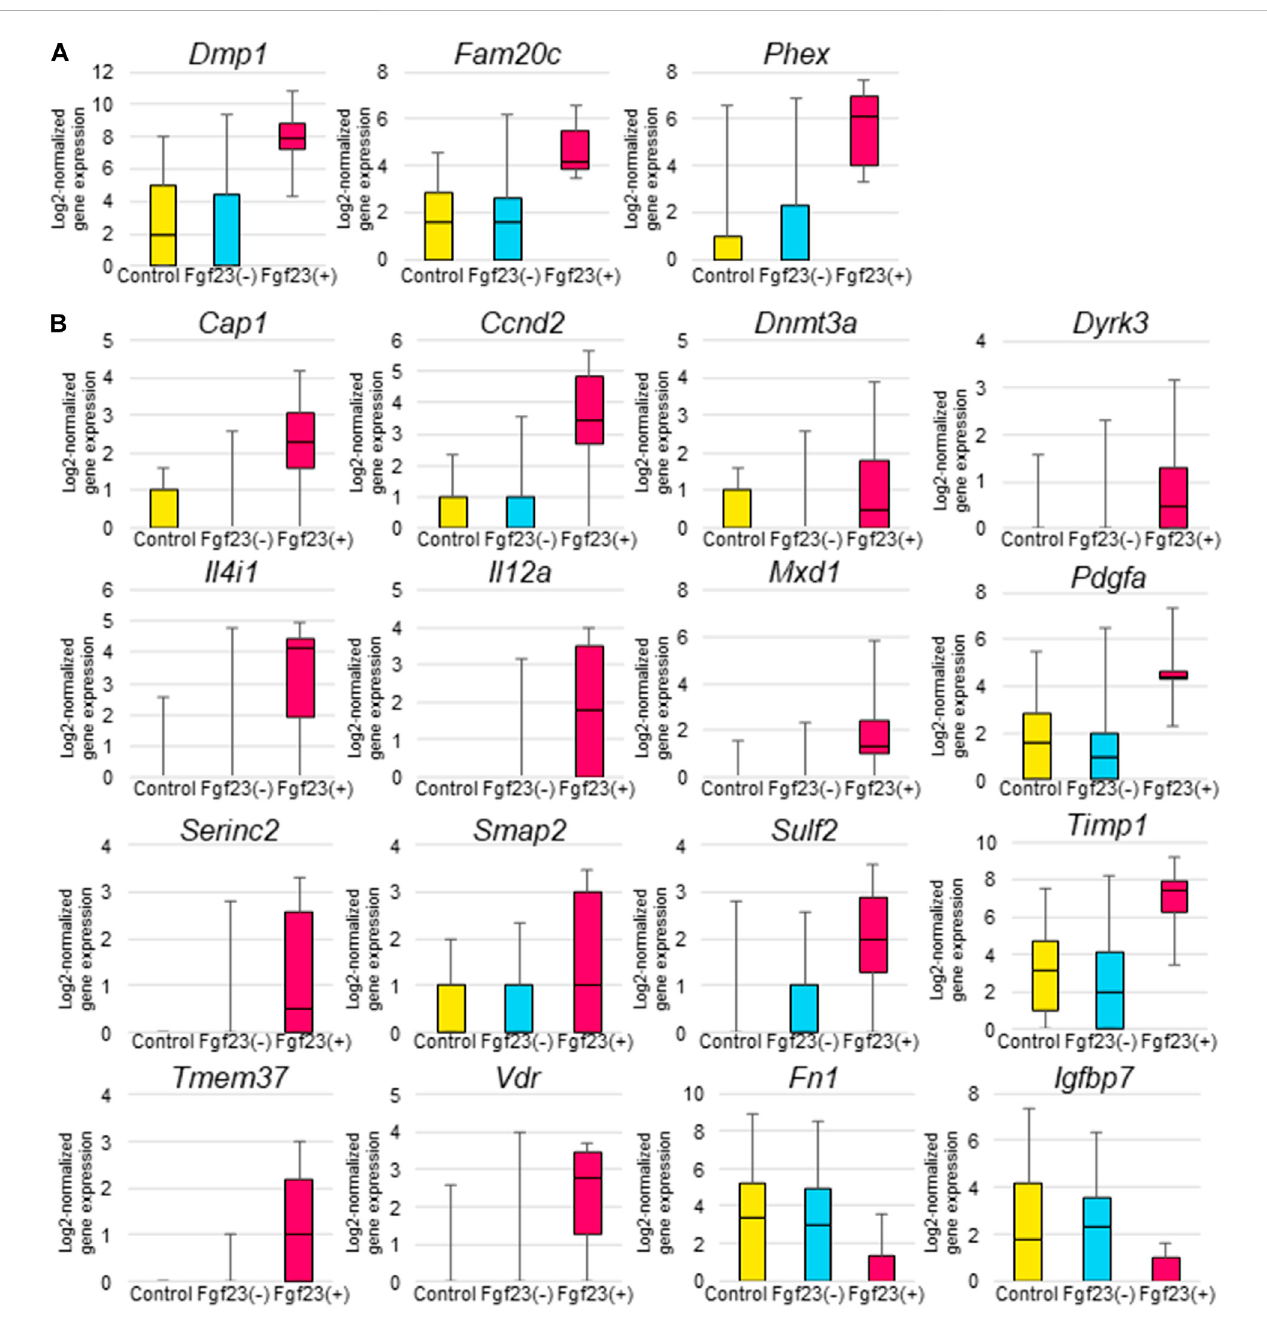
FIGURE 5 Comparison of gene expression levels among Fgf23 -expressing osteocytes and non- Fgf23 -expressing osteocytes from femurs of untreated or calcitriol-injected mice. (A) Box-and-whisker plots indicate Dmp1 , Fam20c , and Phex gene expression in osteocytes from untreated mice, non- Fgf23 - expressing osteocytes from calcitriol-injected mice, and Fgf23 -expressing osteocytes from calcitriol-injected mice. The Y-axes of the plots show log2- normalized gene expression values. (B) Box-and-whisker plots indicate 1,25-dihydroxyvitamin D 3 – stimulated gene expression in untreated osteocytes from untreated mice, non- Fgf23 -expressing osteocytes from calcitriol-injected mice, and Fgf23 -expressing osteocytes from calcitriol-injected mice. The vertical axes of the plots show log2-normalized gene expression